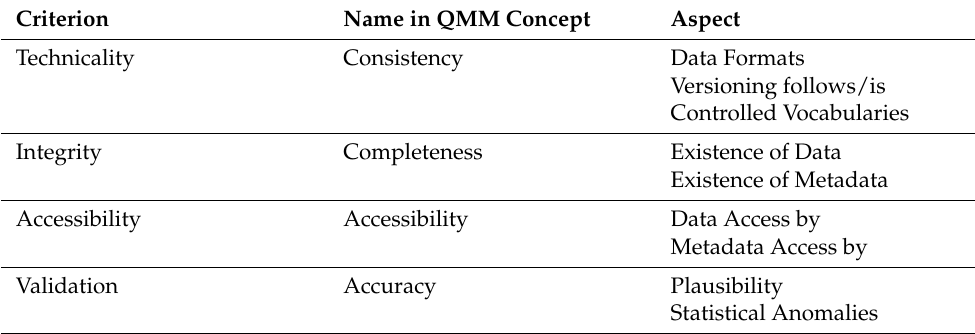
Table 4. Criteria and aspects of data maturity modified from QMM in